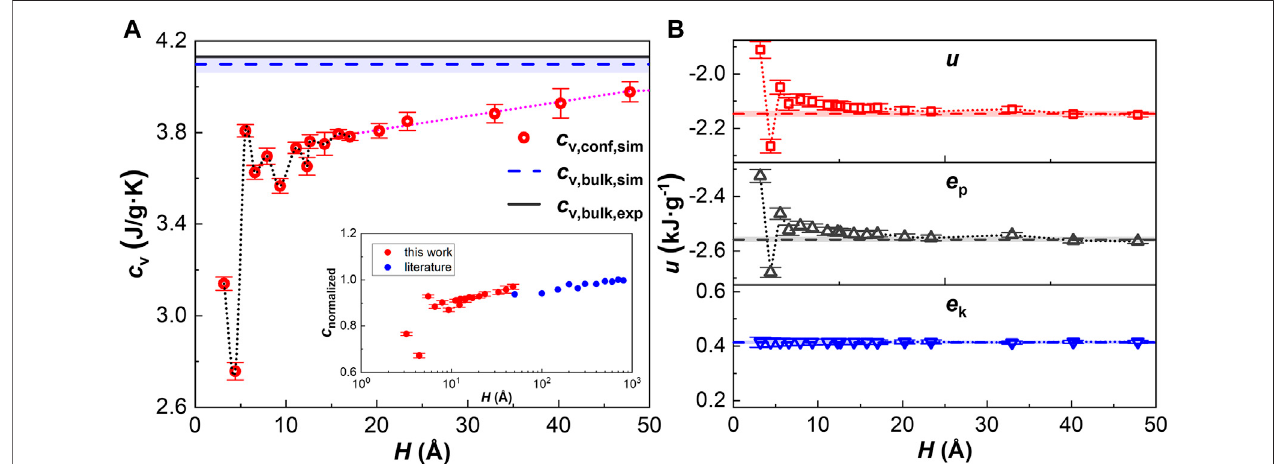
FIGURE 2 | Speci fi c heat capacity and speci fi c internal energy at 300 K. (A) Speci fi c heat capacity as a function of channel size. Dotted black line shows the fl uctuations,dottedbluelinerepresentslinear fi tting,andtheturningpointwheretheyintersectcorrespondstoH (cid:2) 5.5 σ .Inset:literaturecomparison(Jinetal.,2021). (B) Speci fi c internal energy as a function of channel size. Dash lines represent the corresponding bulk value.